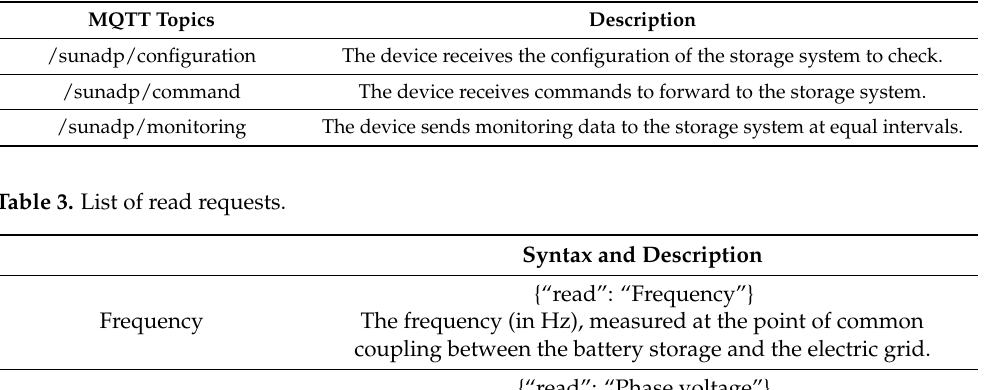
Table 2. List of MQTT topics.